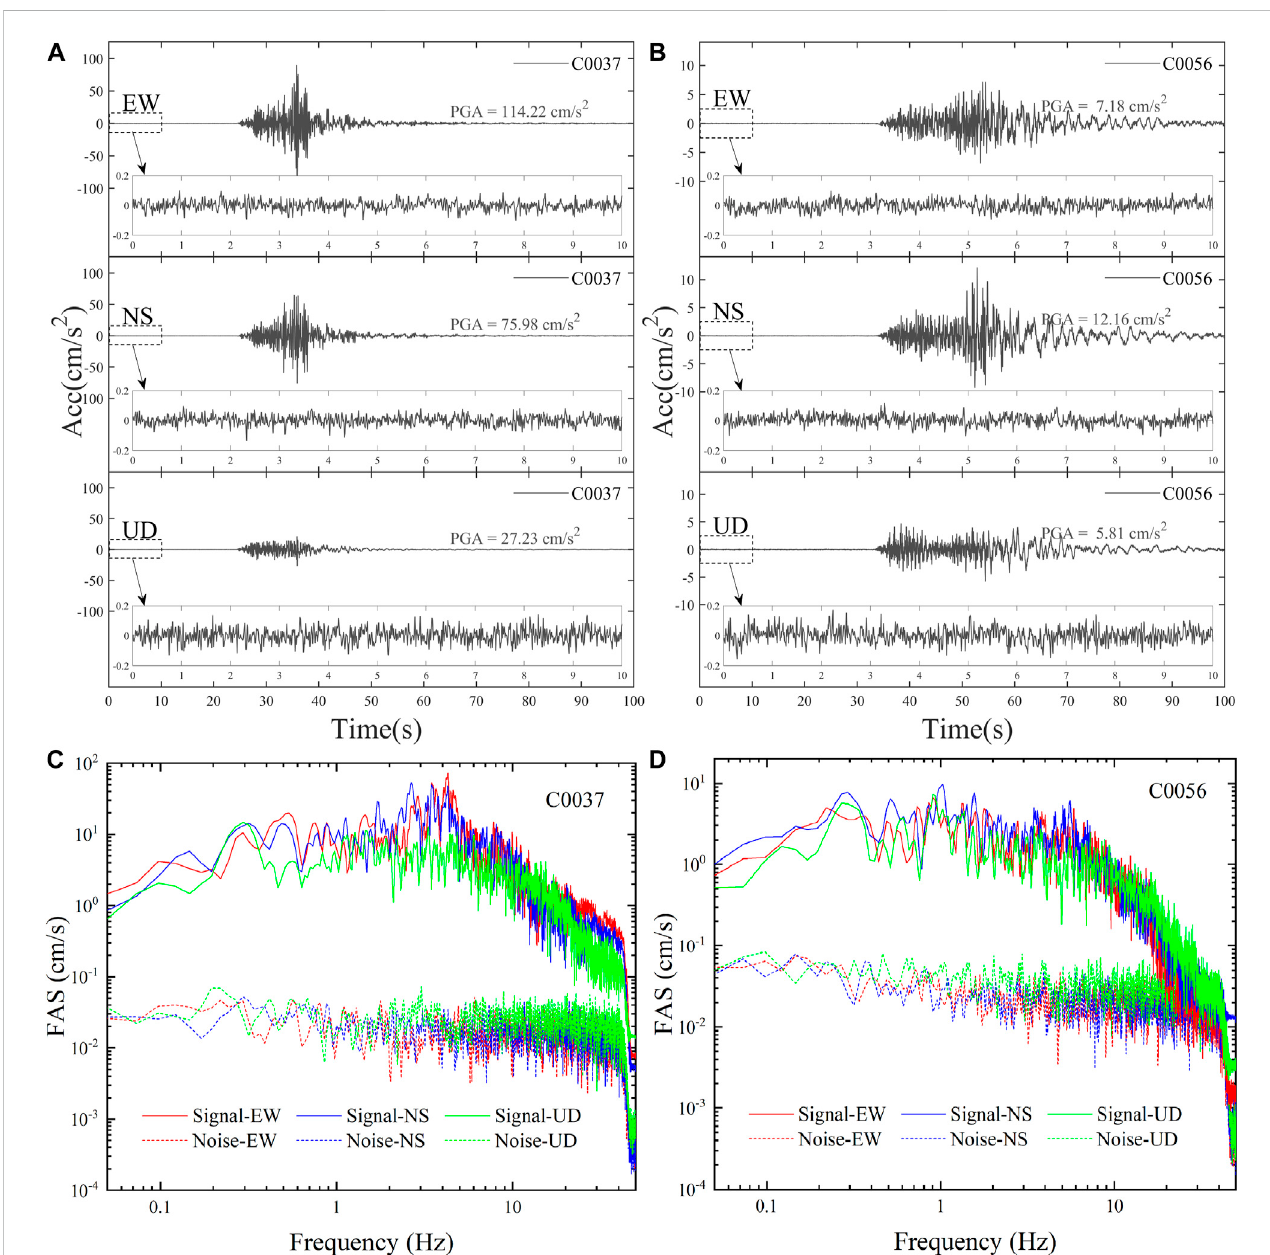
(EW), north-south (NS), and up-down (UD)